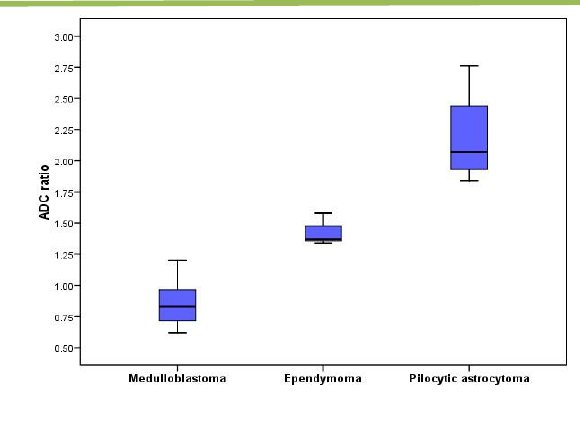
Figure ( 2 ):Box plot of ADC ratio distribution in medullablastoma, ependymoma & JPA